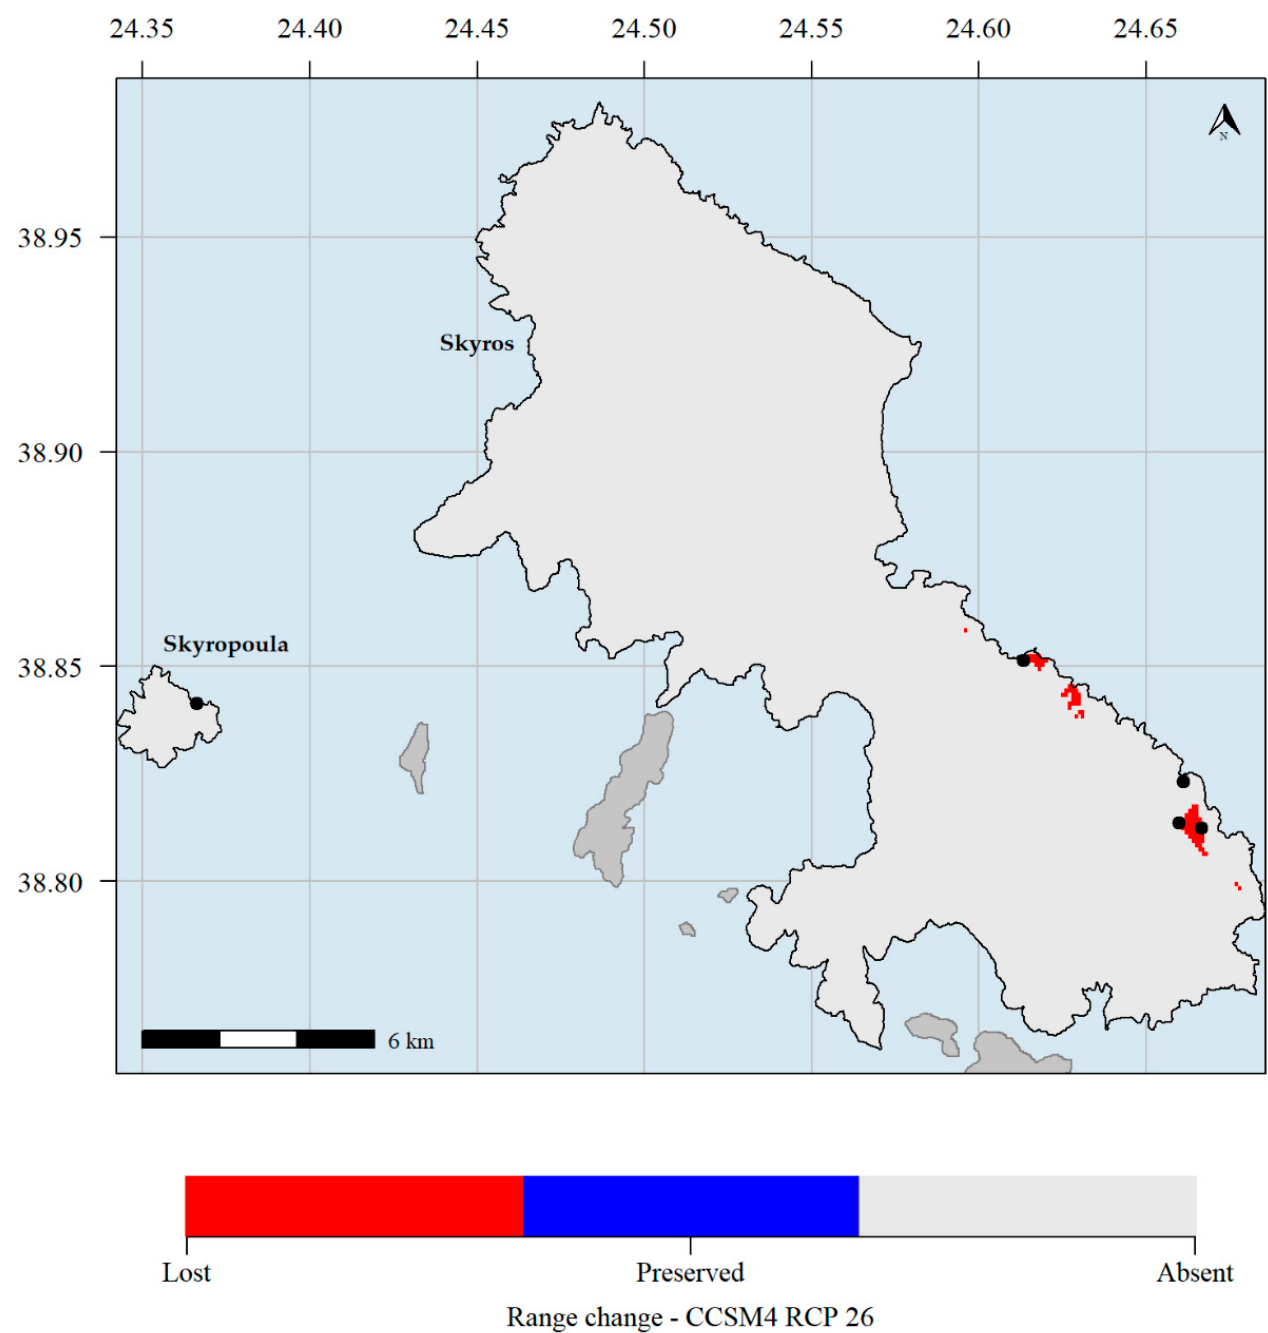
Figure 6. Predicted potential distribution map for 2070 and the CCSM4 global circulation models (GCM) and the representative concentration pathways (RCP) 2.6 scenario. Red grid cells: Aethionema retsina is currently predicted to occupy these areas but will not occupy them in the future. Blue grid cells: Aethionema retsina is currently predicted to occupy these areas and will continue to occupy them in the future. Light grey grid cells: Aethionema retsina is not currently predicted to occupy these areas and it is not predicted to occupy them in the future. Black dots indicate the occurrences of Aethionema retsina in Skyros and Skyropoula. Climate data refer to the WorldClim database. Please note that the black dots in Skyropoula and south-eastern Skyros hide the red cells where the species is predicted to currently occupy.